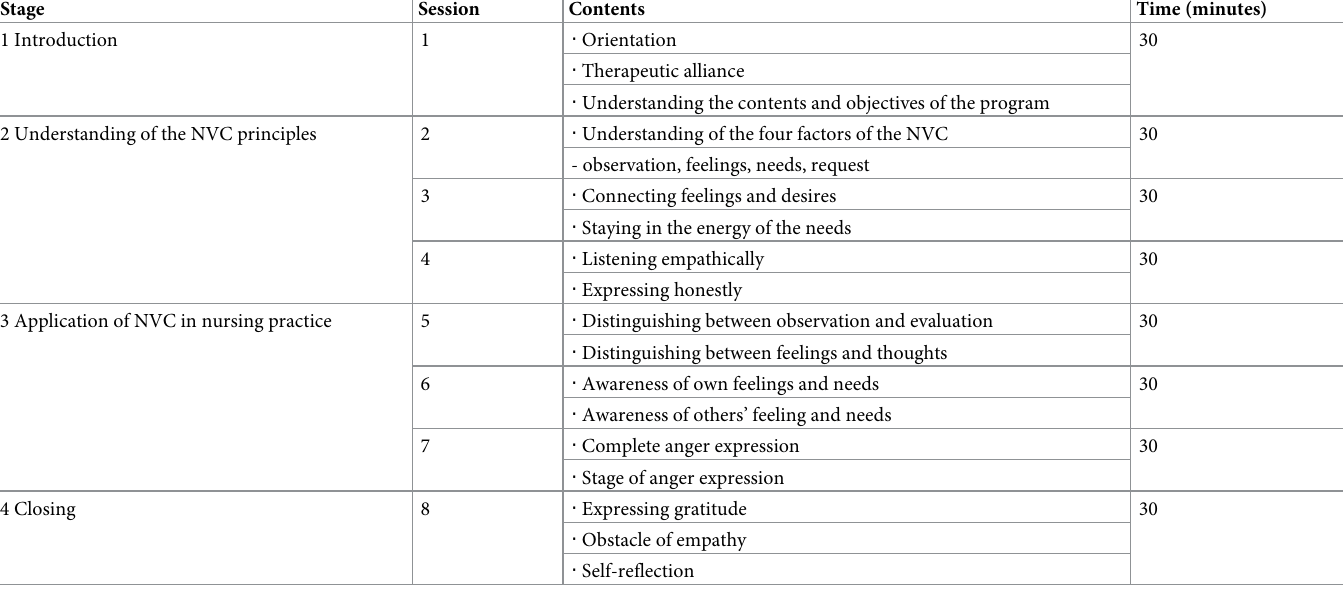
Table 1. Nonviolent communication-based online communication skills training program.